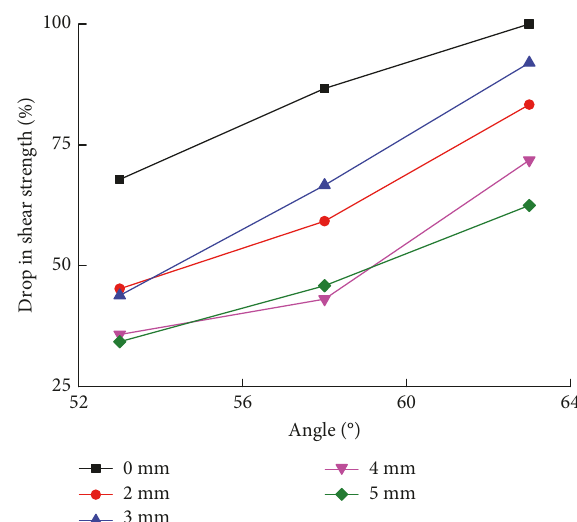
Figure 8: Variation of percentage drop of shear strength of concrete block after peak point with different bolt diameters.